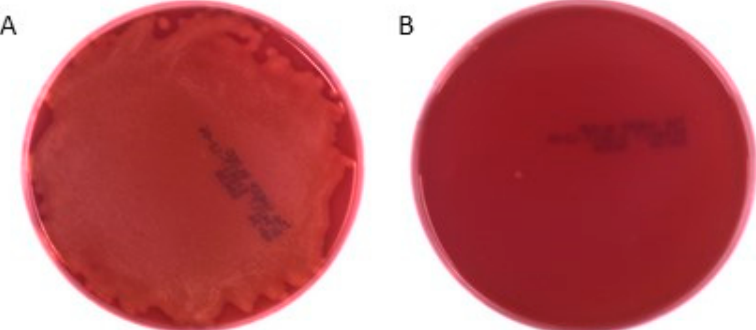
Figure 6. Growth of S. equi after 24h incubation with ( A ) 55 µ g mL − 1 and (B ) 110 µ g mL − 1 of 1,6-dehydropinidine fraction on blood agar. Bacterial growth in ( A ) is visible as lighter colored area covering almost whole plate. Plates are photographed without lid and black markings are from